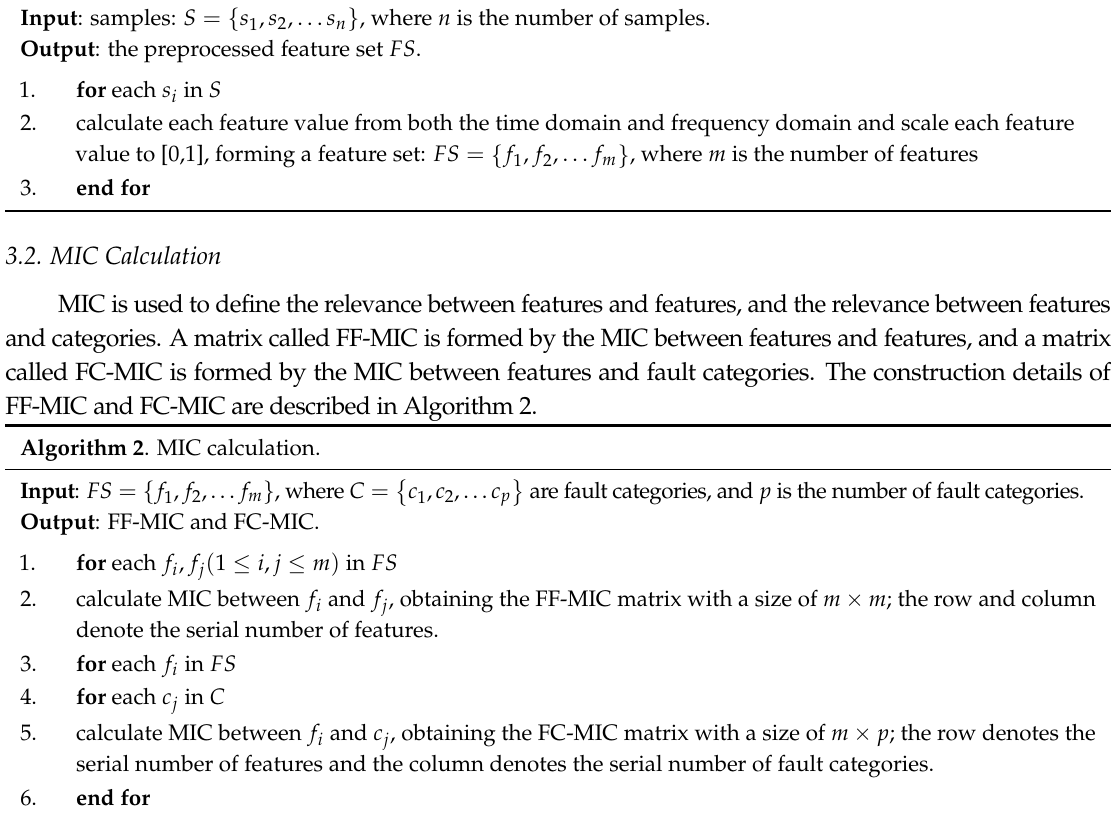
Algorithm 1 . Data preprocessing.